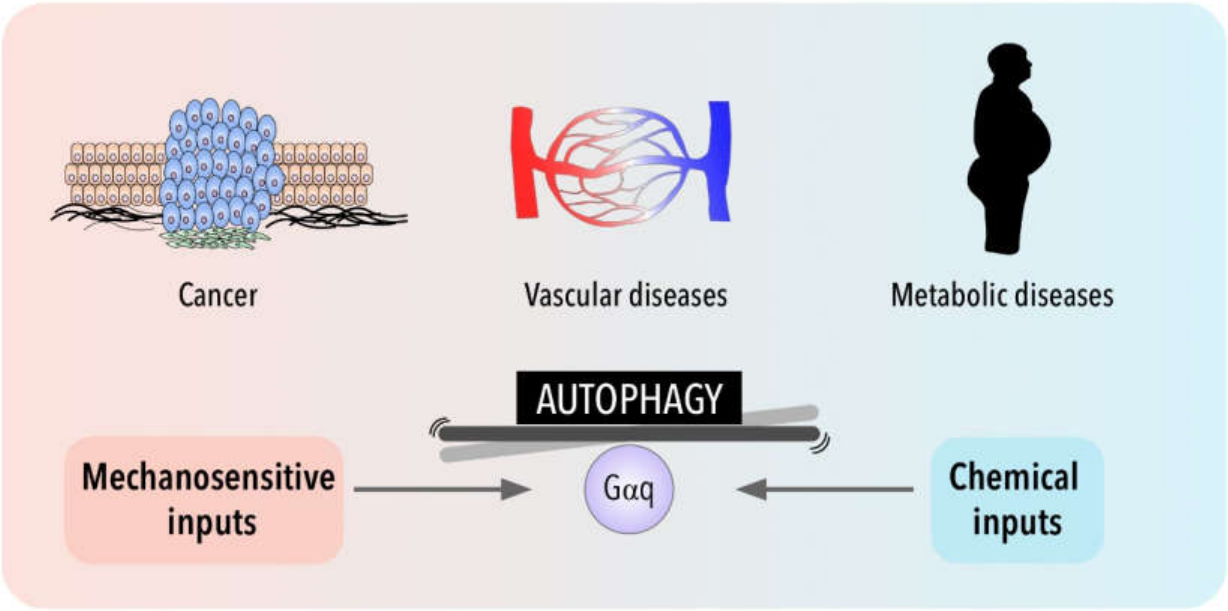
Figure 2. Gαq signaling and autophagy at the crossroads of a balance between mechanical and chemical cues and their impact in cancer, metabolic and cardiovascular pathologies.